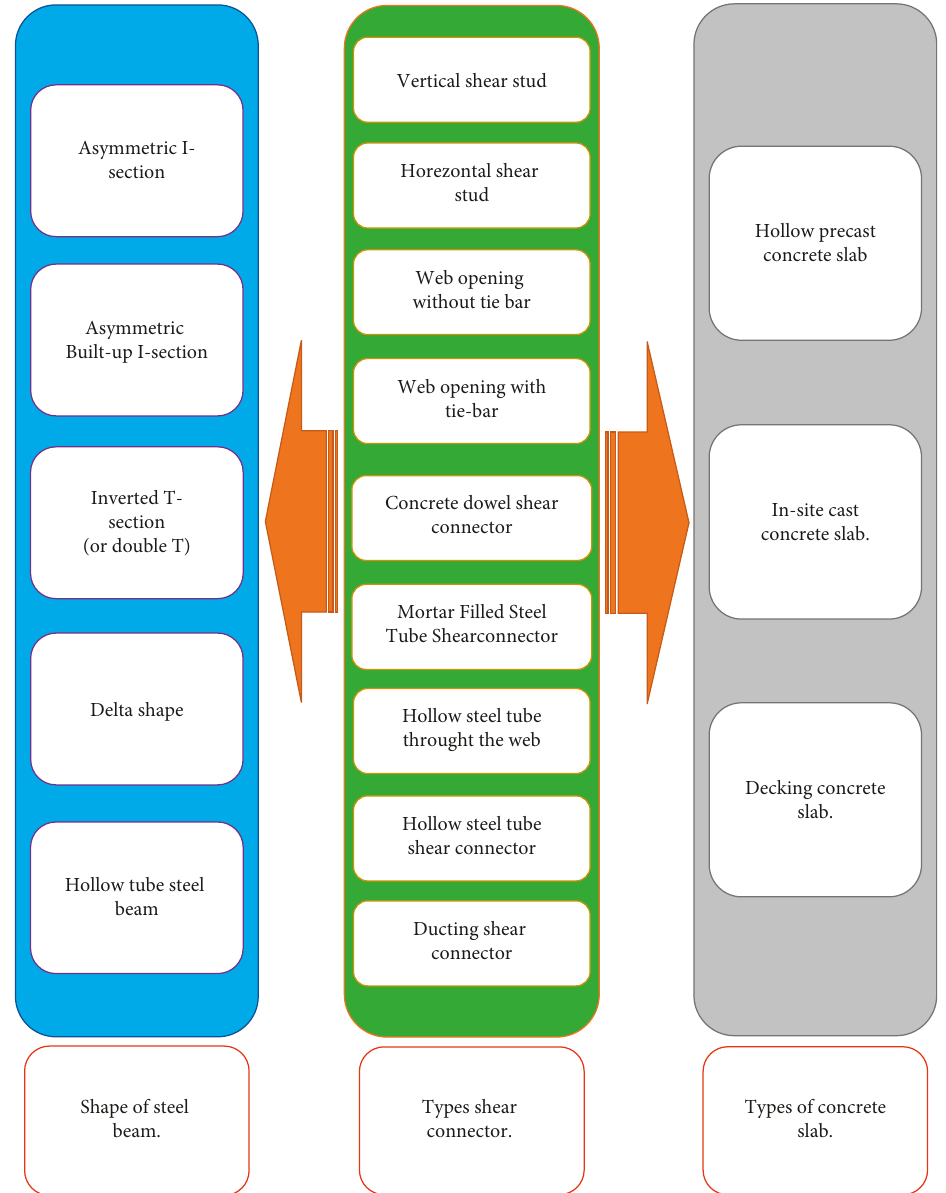
Figure 2: Common components of the composite slim beam, steel beam, shear connectors, and concrete